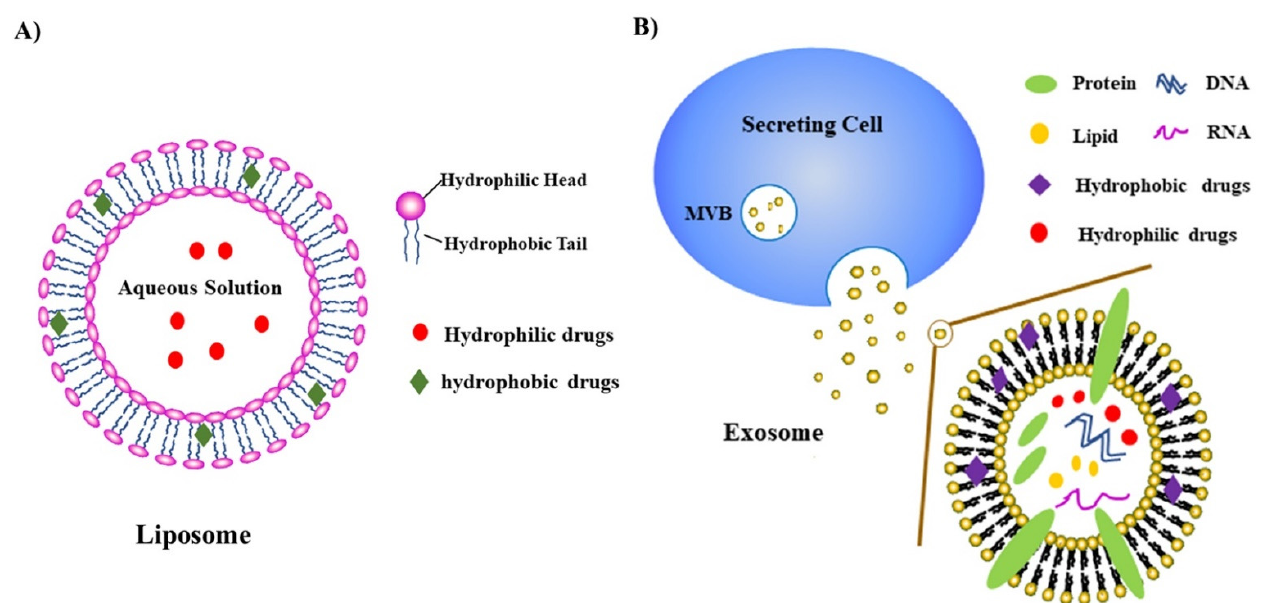
Figure 1. Structure of liposomes ( A ) and exosomes ( B ). ( A ) The liposome is a spherical vesicle with one or more phospholipid bilayers. Drugs can be encapsulated in the aqueous core of the liposome or within the phospholipid bilayer. ( B ) Exosomes, which can also encapsulate various drugs and particles, are small extracellular vesicles (EVs) secreted by mammalian cells, containing multiple proteins, lipids, and nucleic acids. They are also referred to as natural biomimetic nano- particles.